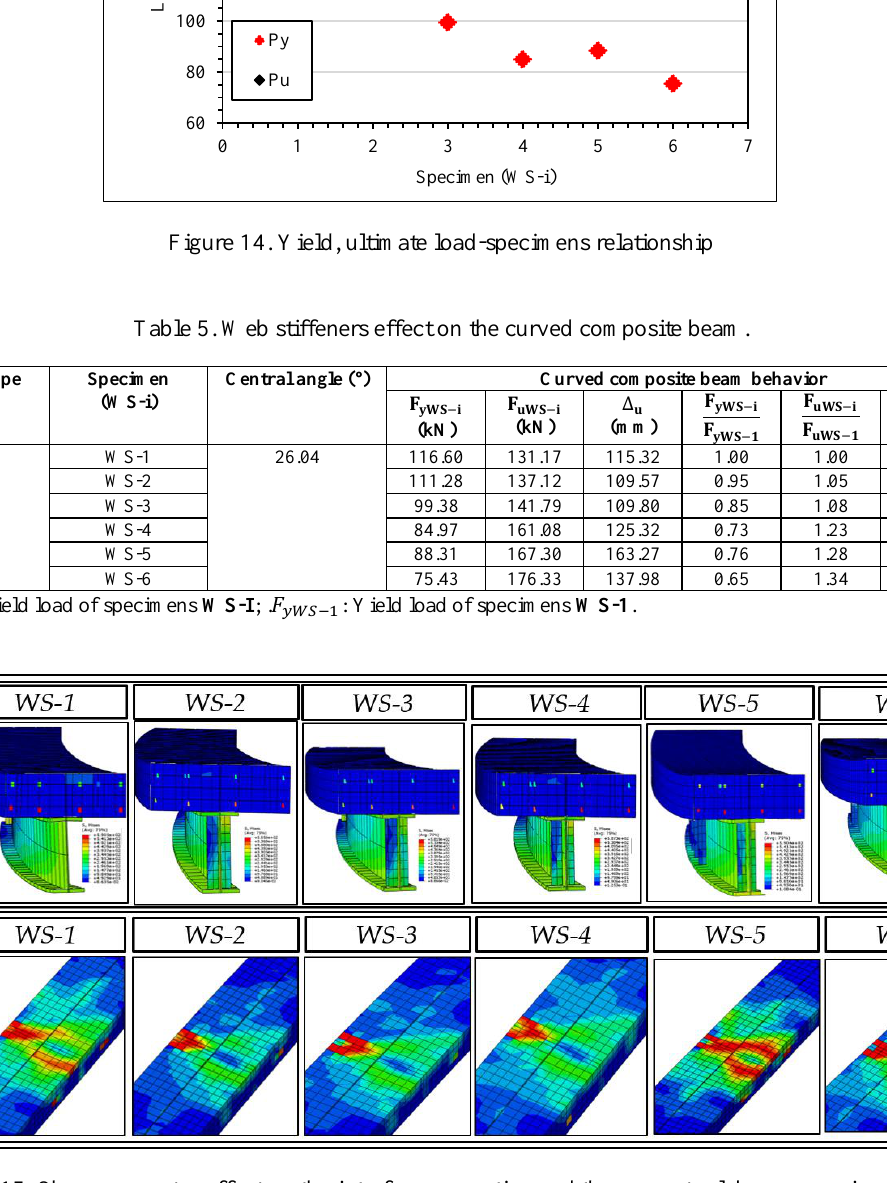
Figure 15. Shear connector effect on the interface separation and the concrete slab compression